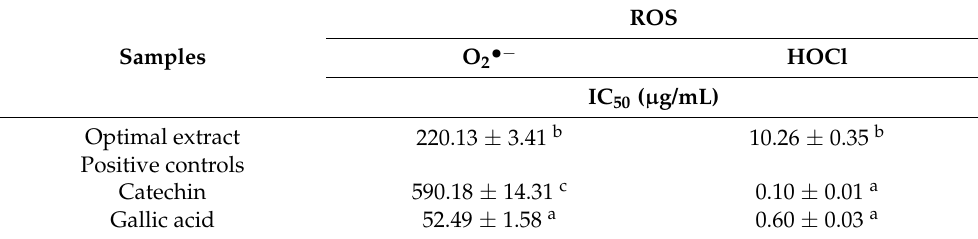
Table 5. Superoxide anion radical (O 2 •− ) and hypochlorous acid (HOCl) scavenging capacities of the optimal extract of kiwiberry leaves. Different letters ( a , b , c ) in the same column mean significant differences ( p < 0.05) between